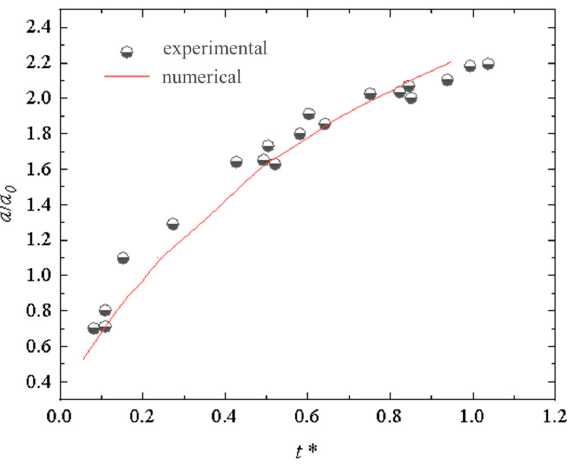
Figure 8. The spreading coefficient trend comparison of the simulation and experiment.